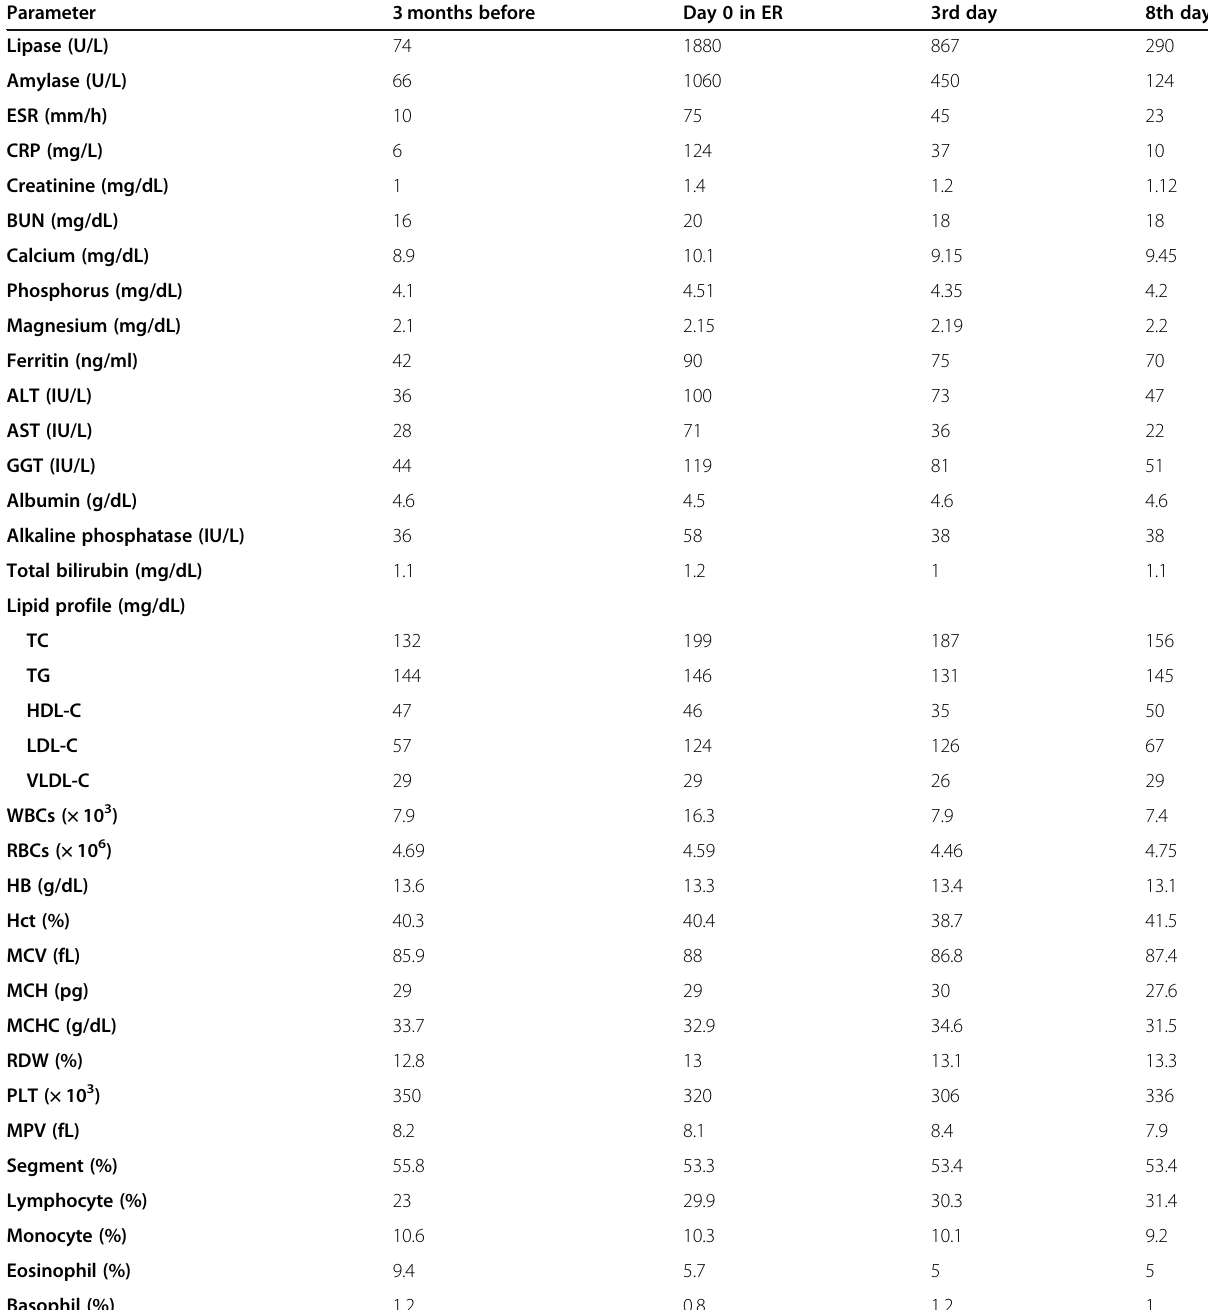
Table 1 Laboratory parameters of the patient before and throughout acute